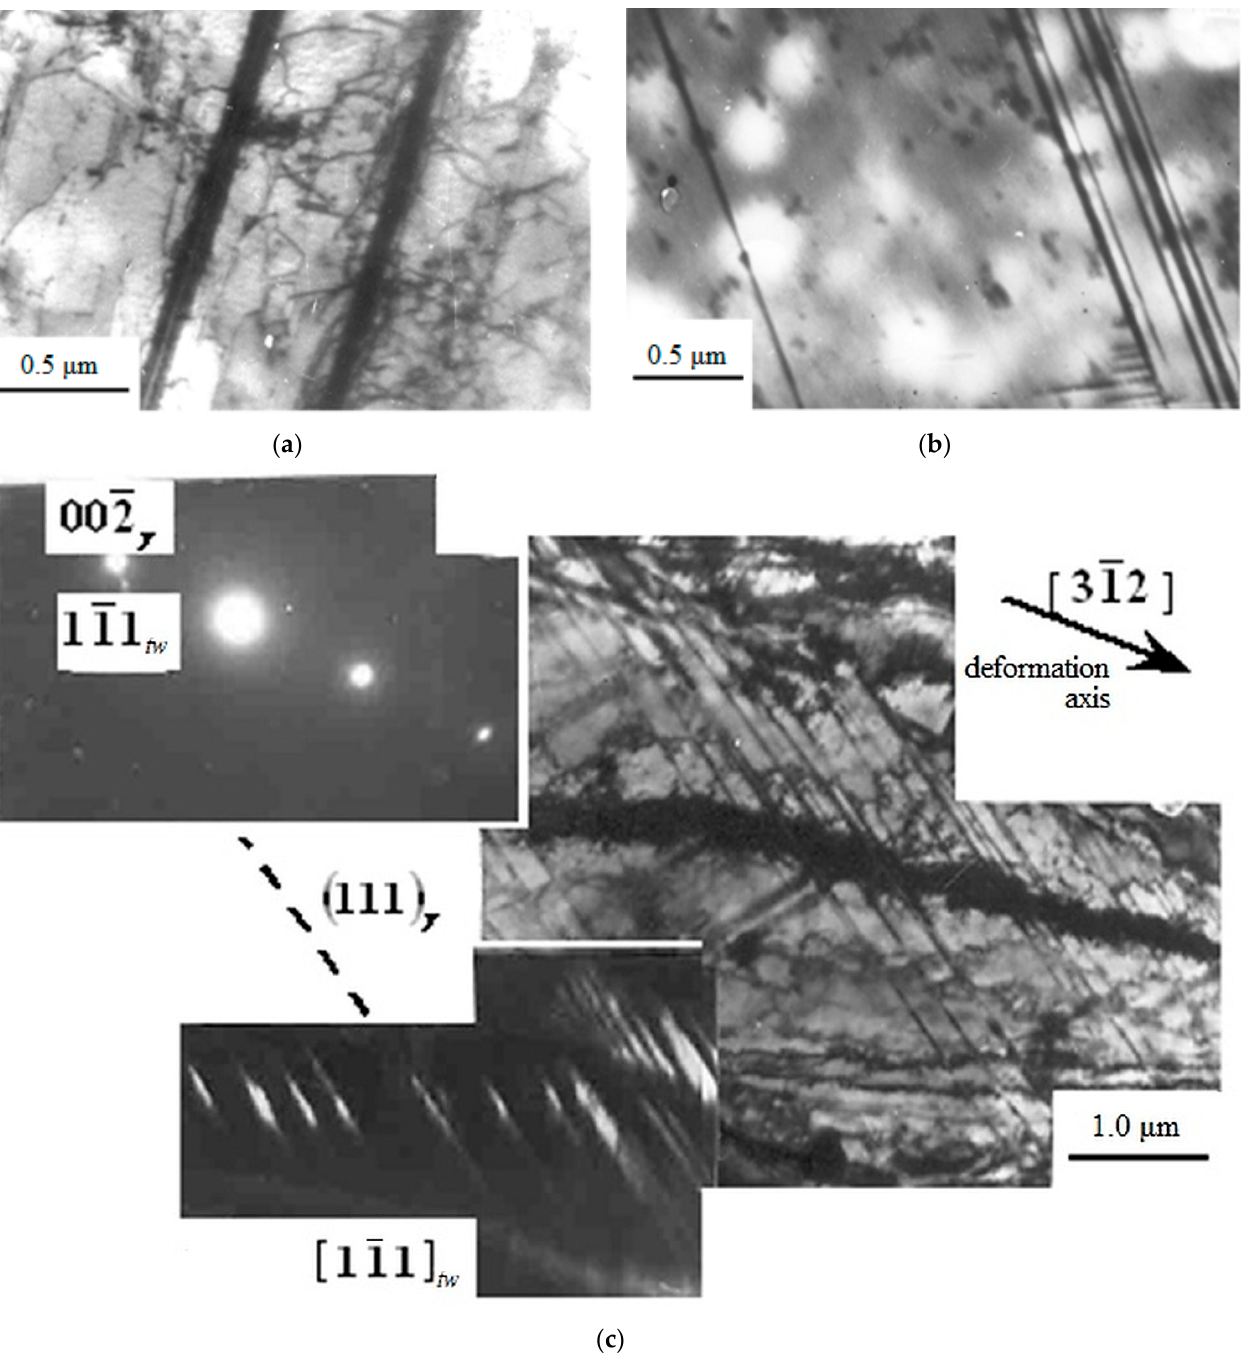
Figure 10. Microtwinning in Hadfield steel during tensile deformation with: ( a ) ε = 10%; ( b ) ε = 15%; ( c ) ε = 25%. The figure indicates the axis of deformation and the twinning plane trace (----), as well as the diffraction pattern with an indication of the twin [111] tw reflection, in which a dark-field image was taken.